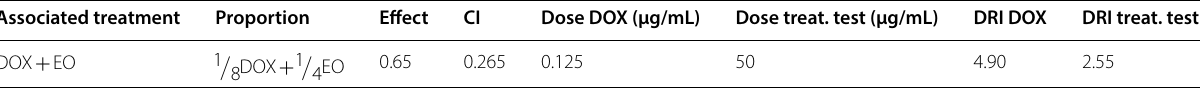
Table 2 Proportion, effect, combination index (CI), minimum dose and caloric reduction index (DRI) of the associations between doxycycline and the essential oil test treatment of A. conyzoides